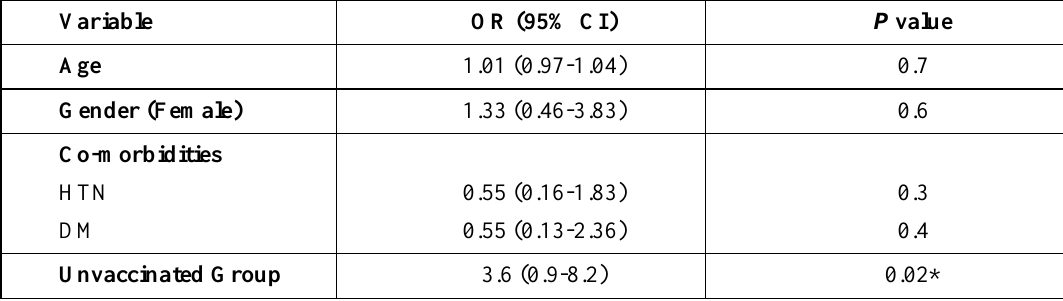
Table III. Univariate logistic regression for predictors of developing COVID-19 infection (n=25). Variable